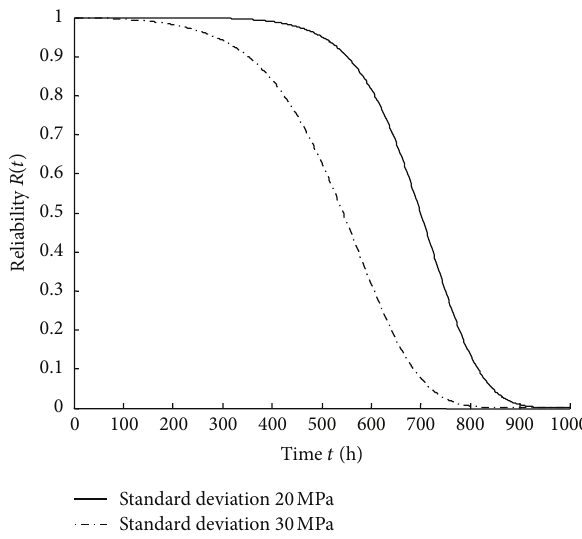
Figure 3: Reliability curves with different standard deviations of 𝑟 0 .